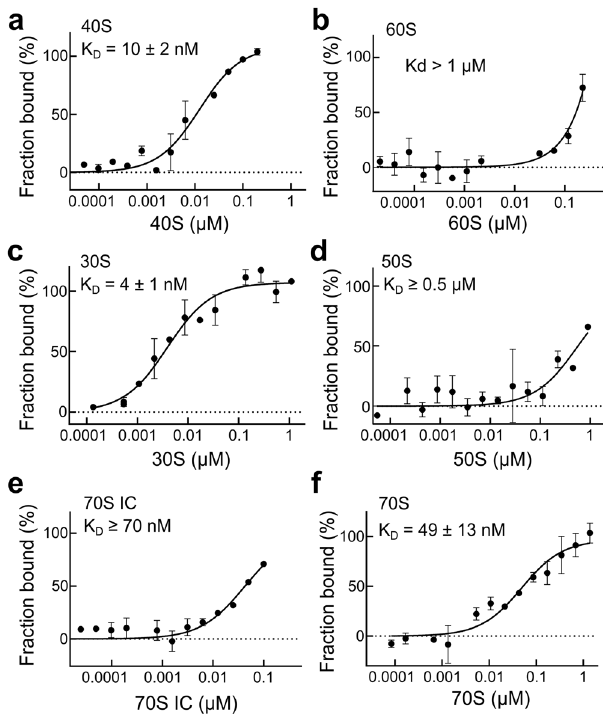
Fig. 4 2A binds directly to eukaryotic and prokaryotic ribosomes. a MST binding curves and apparent K D values using unlabelled 40S subunits at a concentration range of 20 pM – 0.4 μ M. All measurements were repeated as two independent experiments and error bars represent the standard deviation from the mean. 2A binds with high af fi nity to the small ribosomal subunit. b As in a with 60S subunits. Error bars as above. c Binding curve and apparent K D values using unlabelled 30S subunits at a concentration range of 30 pM – 1 μ M. Error bars as above. 2A shows a strong interaction with the prokaryotic small subunit. d As in c with 50S subunits at a concentration range of 27 pM – 0.9 μ M. e Binding curves and reported K D values for 2A-70S IC interactions. Error bars as above. f Same as e , with 2A and vacant 70S. Source data are provided as a Source Data fi